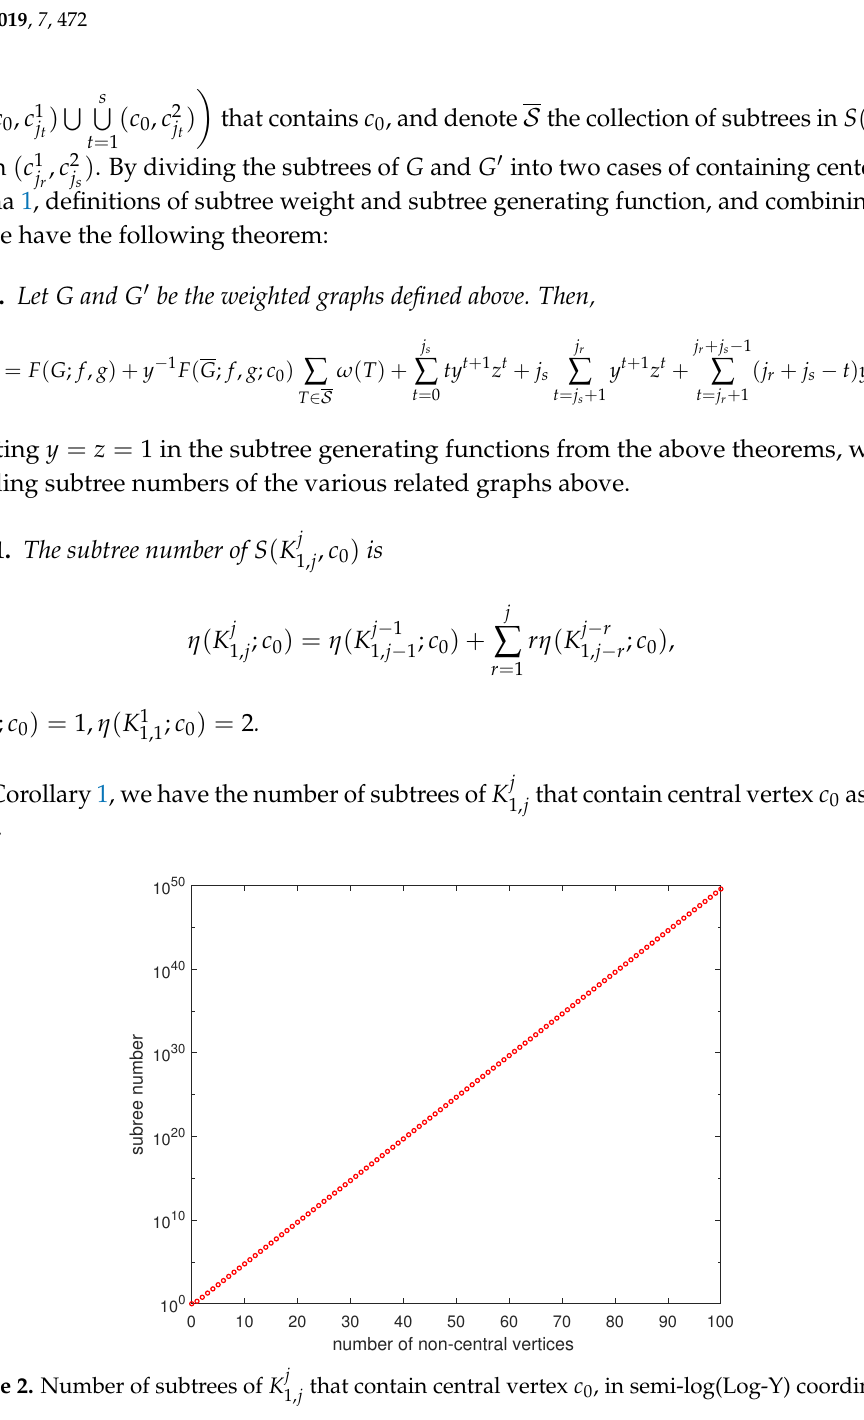
that contain central vertex c 0 , in semi-log(Log-Y) 1, j